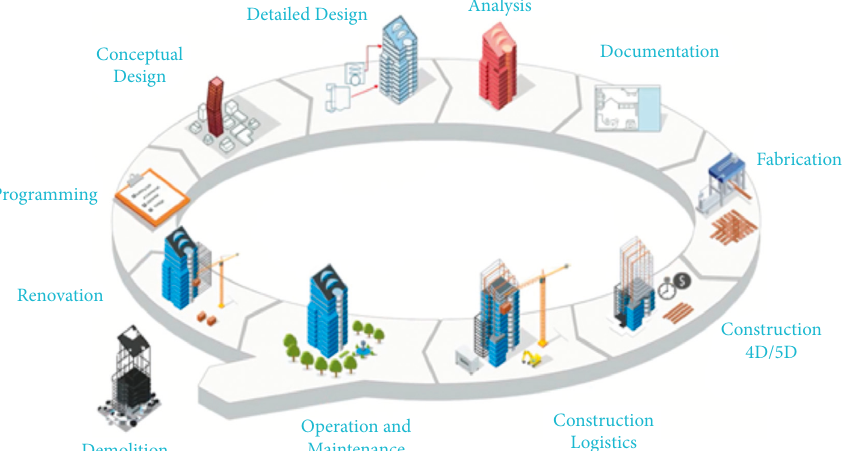
Figure 6: BIM utilization in a different area of